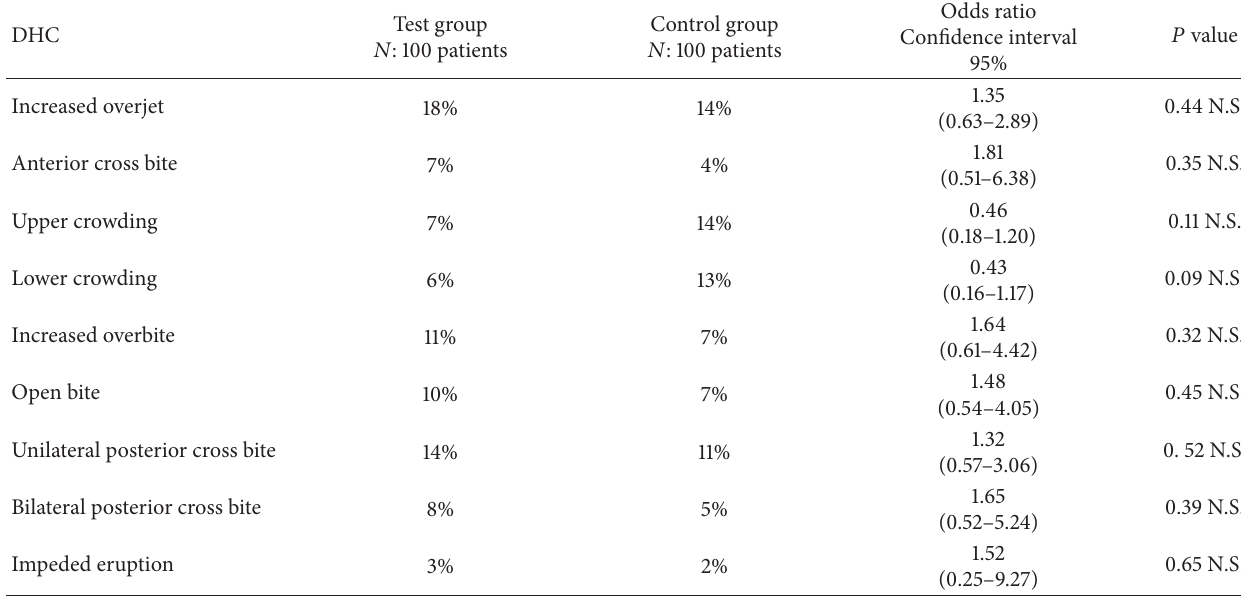
Table 4: Prevalence of the types of malocclusion (DHC of the IOTN) in the test and in the control groups, with the indication of significant differences. DHC